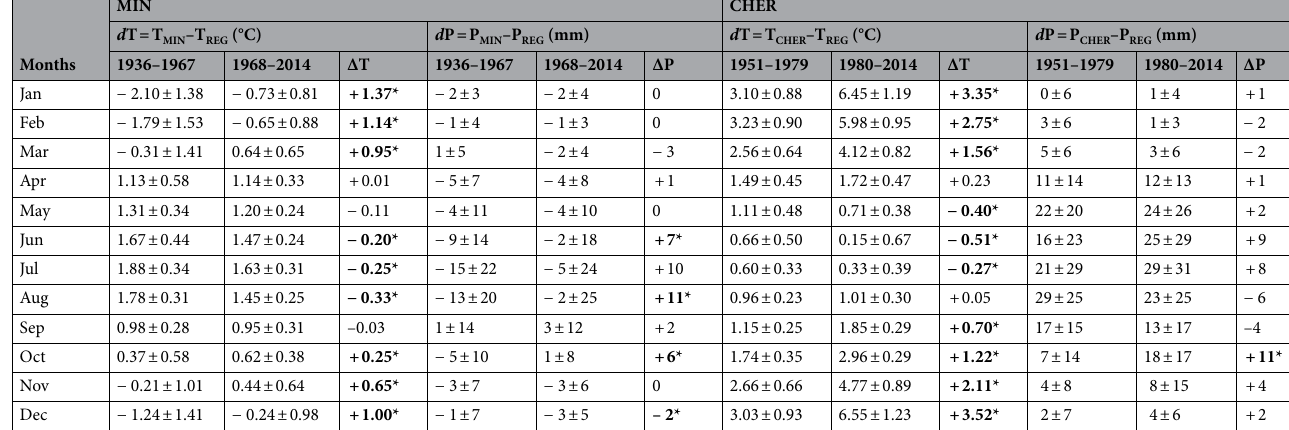
Table 2. Impact of reservoirs on difference of local and regional climate. For each monthly climate variable and station (Minusinsk—MIN, Cheryomushki—CHER), the first two columns show mean ± standard deviation of the difference d between station and regional (REG; see text) values over sub-periods before and after launching of the turbines in the respective dams; the third column (Δ) indicates the change in that difference from the earlier to later sub-period, significant ( p < 0.05) changes are written in bold.